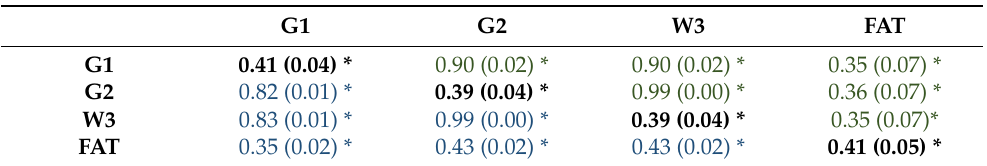
Table 4. Genetic parameters for growth at different stages and fat. Heritability is on the diagonal in bold; genetic and phenotypic correlations are above (in green) and below (in blue) the diagonal, respectively. Standard errors are illustrated in the parentheses.